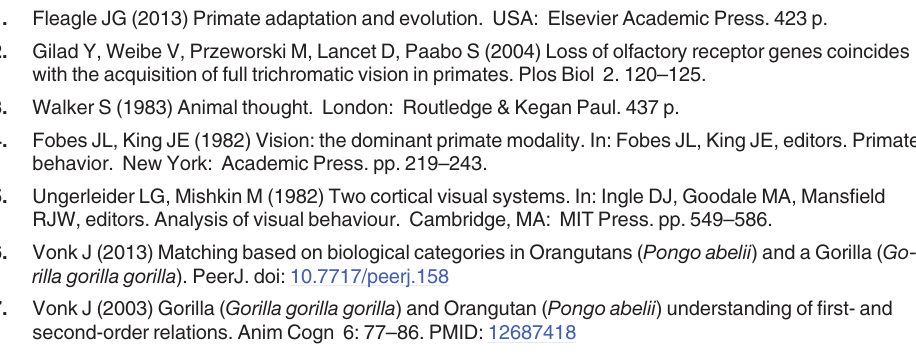
S1 Table. Individual data for Experiment 1. S2 Table. Individual data for Experiment